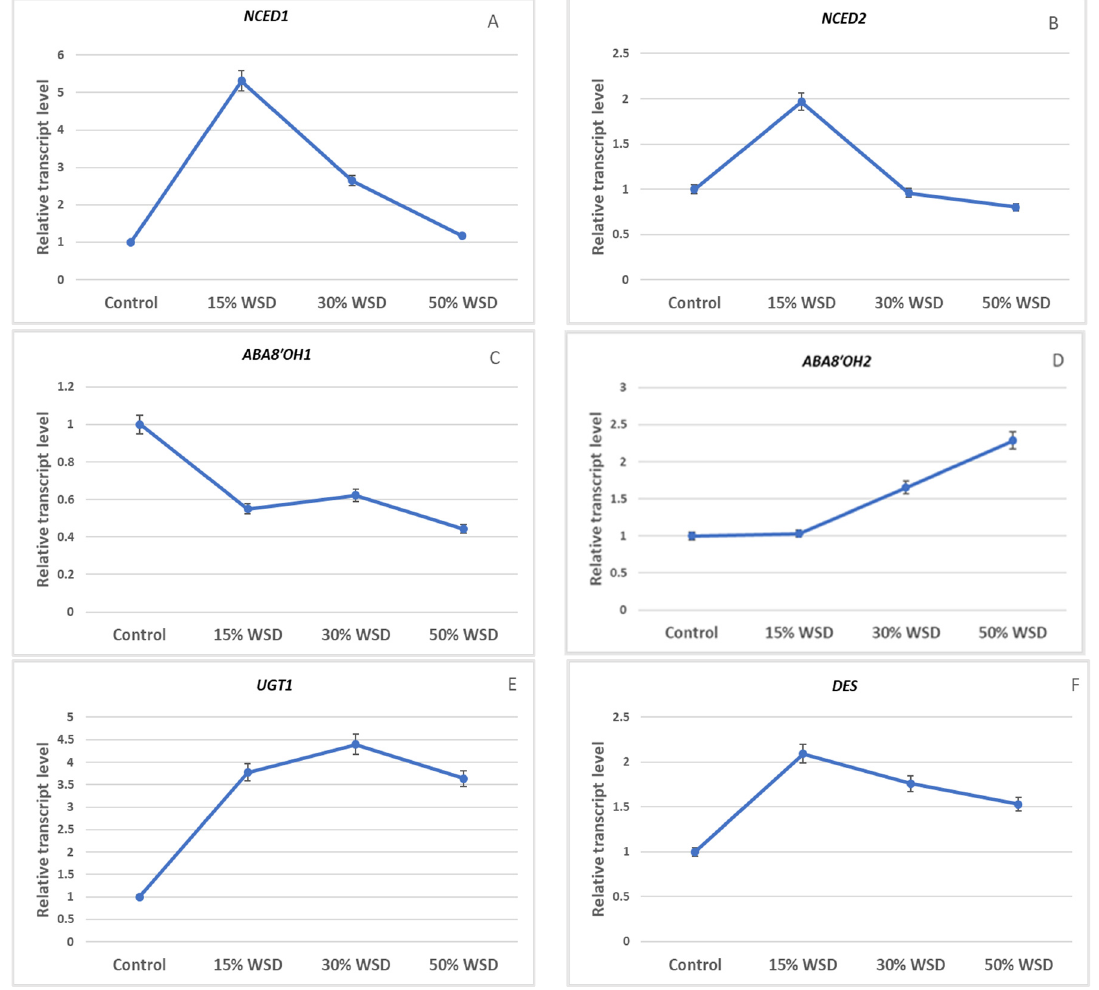
Figure 5. Transcript levels of NCED1 ( A ), NCED2 ( B ), ABA8 ′ OH1 ( C ), ABA8 ′ OH2 ( D ), UGT1 ( E ) and DES ( F ) in the control and dehydrated plants to 15%, 30%, and 50% WSD. Vertical bars indicate means ± standard deviation of at least three technical replicates of semi-quantitative reverse transcription-PCR performed for each of the two biological replicates.